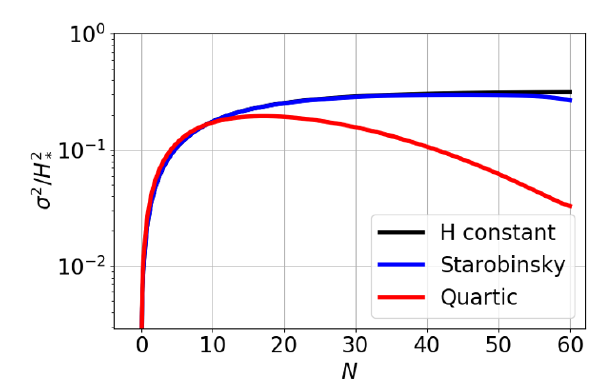
Figure 3. Impact of the time dependence of the Hubble scale H on the evolution of the variance of the Higgs (cid:12)eld. The three curves correspond to the solution (2.20) with f = 1, for di(cid:11)erent background evolutions: constant H , Starobinsky in(cid:13)ation and quartic in(cid:13)ation, all having the same value of the Hubble scale H ? 60 e -folds before the end of in(cid:13)ation, (cid:24) = (cid:0) 0 : 01, and C 5 = C 6 = 0 in (2.14). While in the plateau case the system almost relaxes towards the corresponding de Sitter equilibrium, the (cid:12)nal variance di(cid:11)ers by one order of magnitude in the quartic